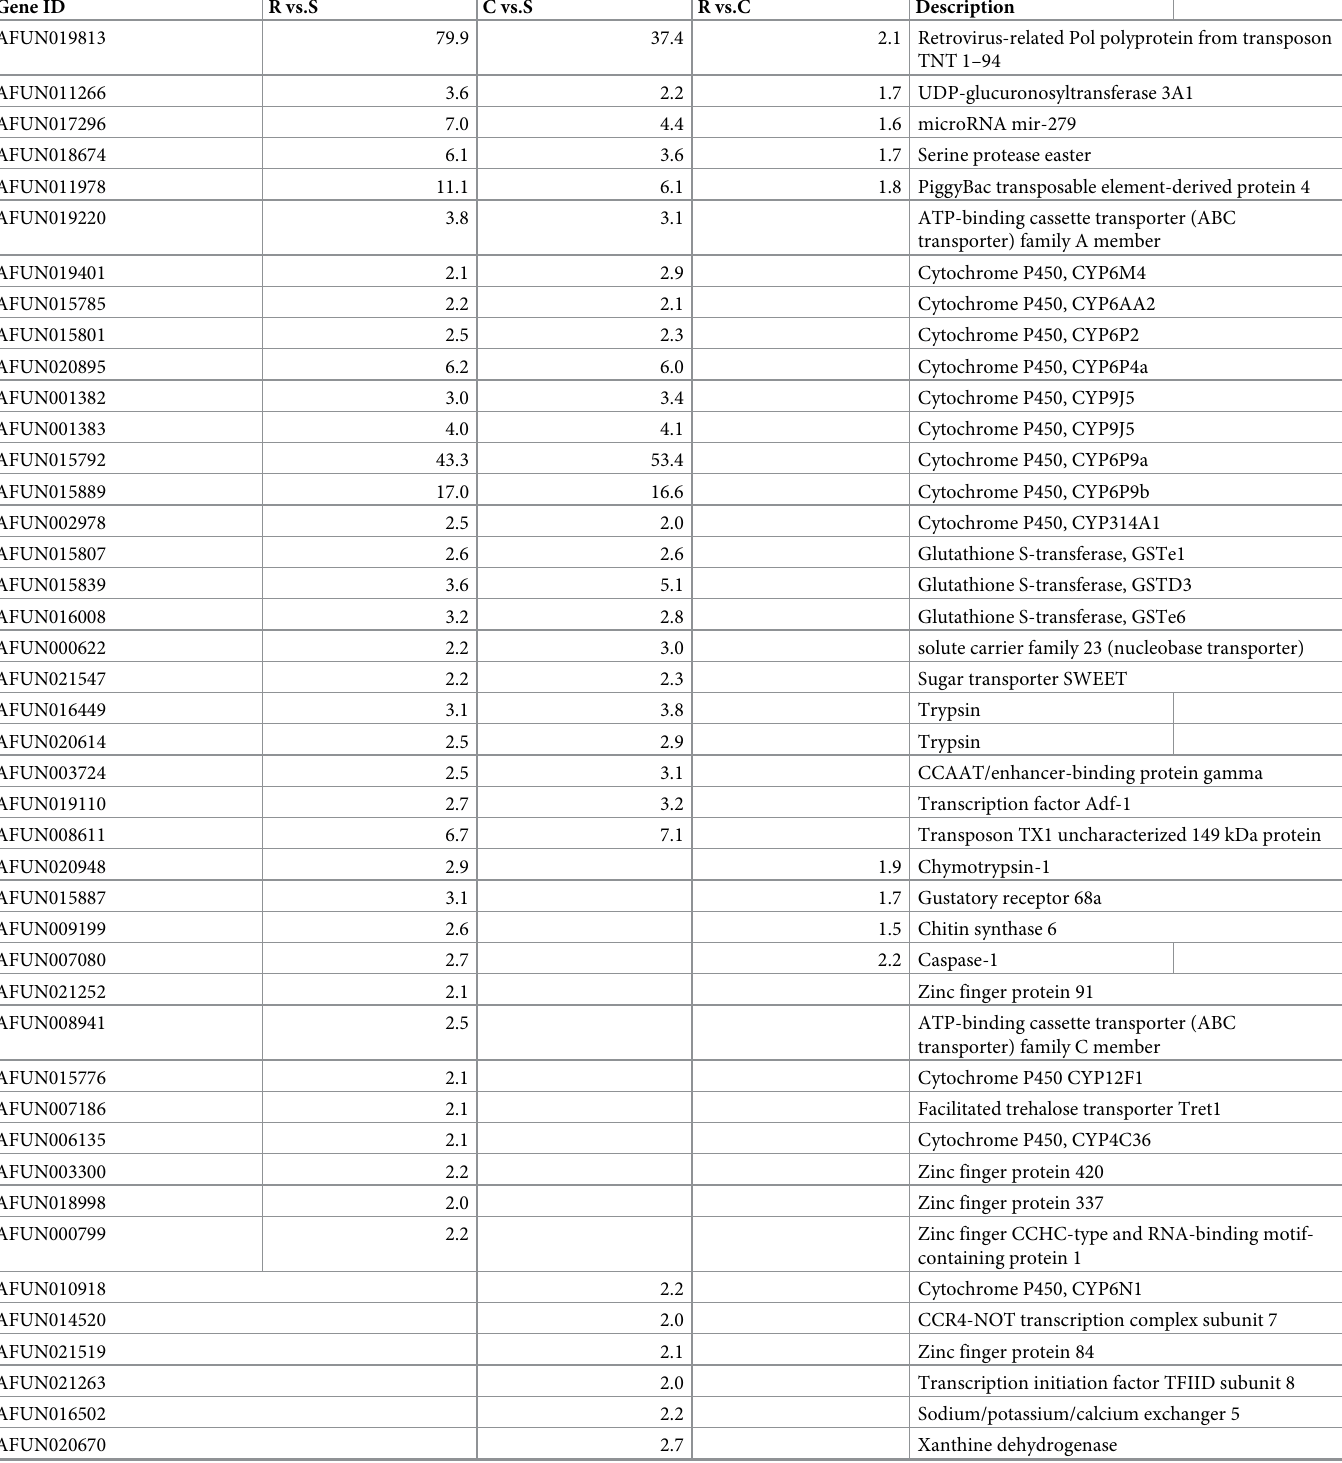
Table 1. List of resistance associated transcripts commonly over-expressed between bendiocarb resistant (R), unexposed An . funestus (C) from Malawi and the FANG susceptible (S) strain at fold-change > 2 (or 1.5 for R vs. C) FDR < 0.05. Gene ID R